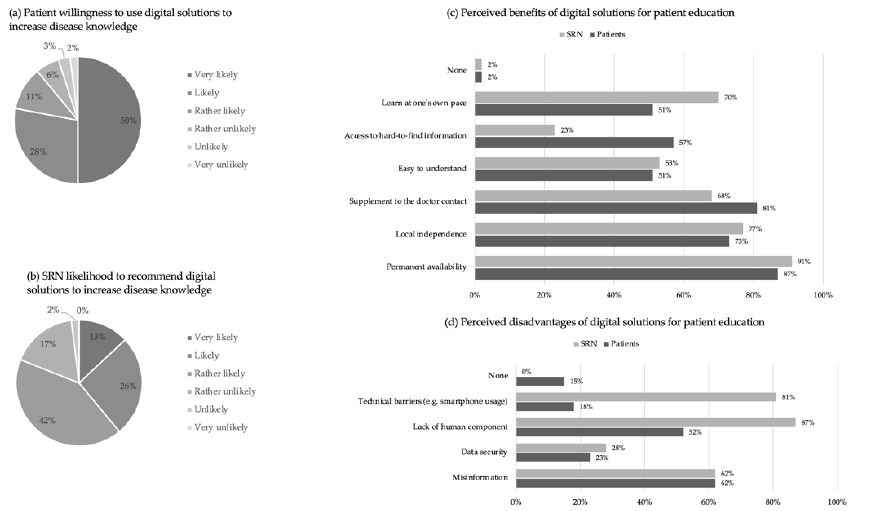
Figure 3. Patient and SRN willingness to use/recommend digital solutions to increase disease knowledge with perceived benefits and disadvantages. ( a – d ) Data is displayed as the percentage of total patients and SRN that responded to the question.